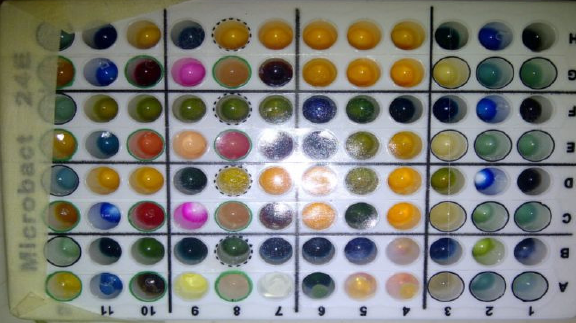
Plate 2. Color change in the Microbact wells after 24 hours